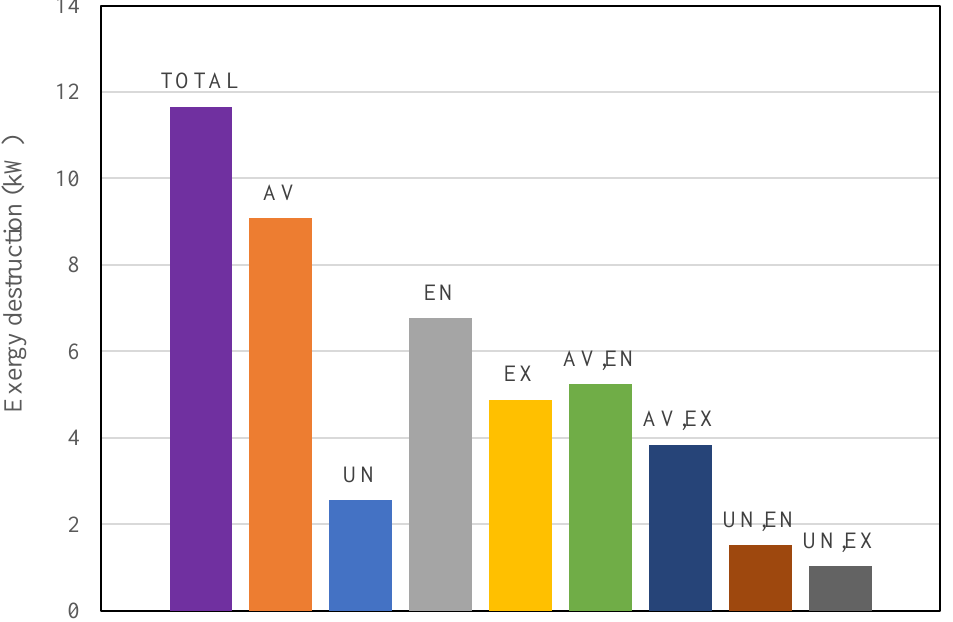
Figure 9. Total exergy destruction rate for the different parts in DRORC.